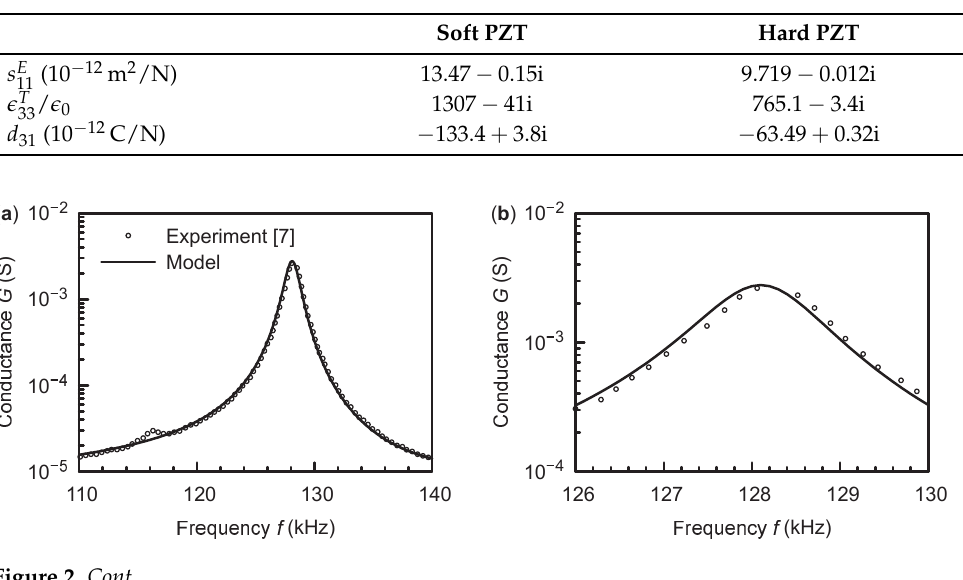
Table 1. The optimal material constants of the soft PZT and the hard PZT. (cid:101) 0 = 8.854 × 10 − 12 F/m is the vacuum permittivity.